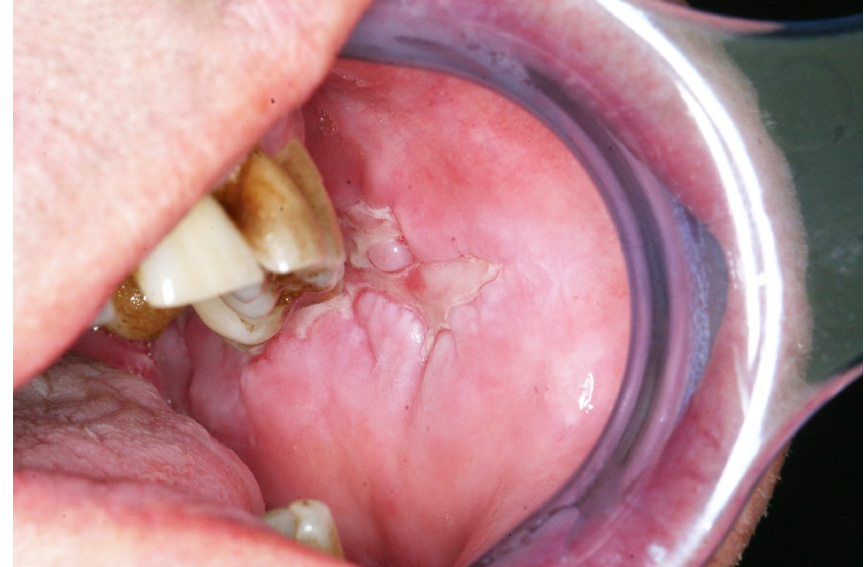
Figure 3. Paraneoplastic pemphigus (oral lesion). Obligate paraneoplastic dermatosis characterized by painful mouth ulcerations. It is usually associated with myeloproliferative and lymphoproliferative disorders.